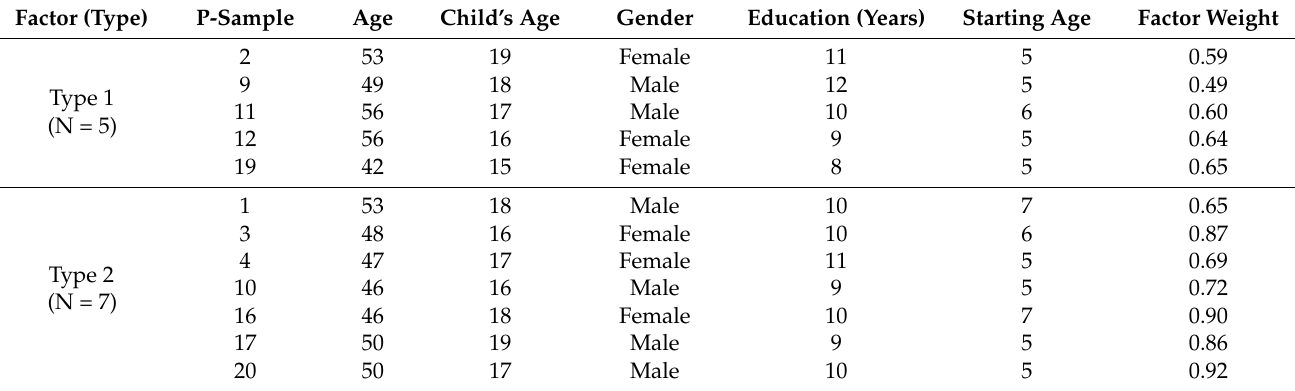
Table 2. Summary of characteristics of the P-sample and a defining